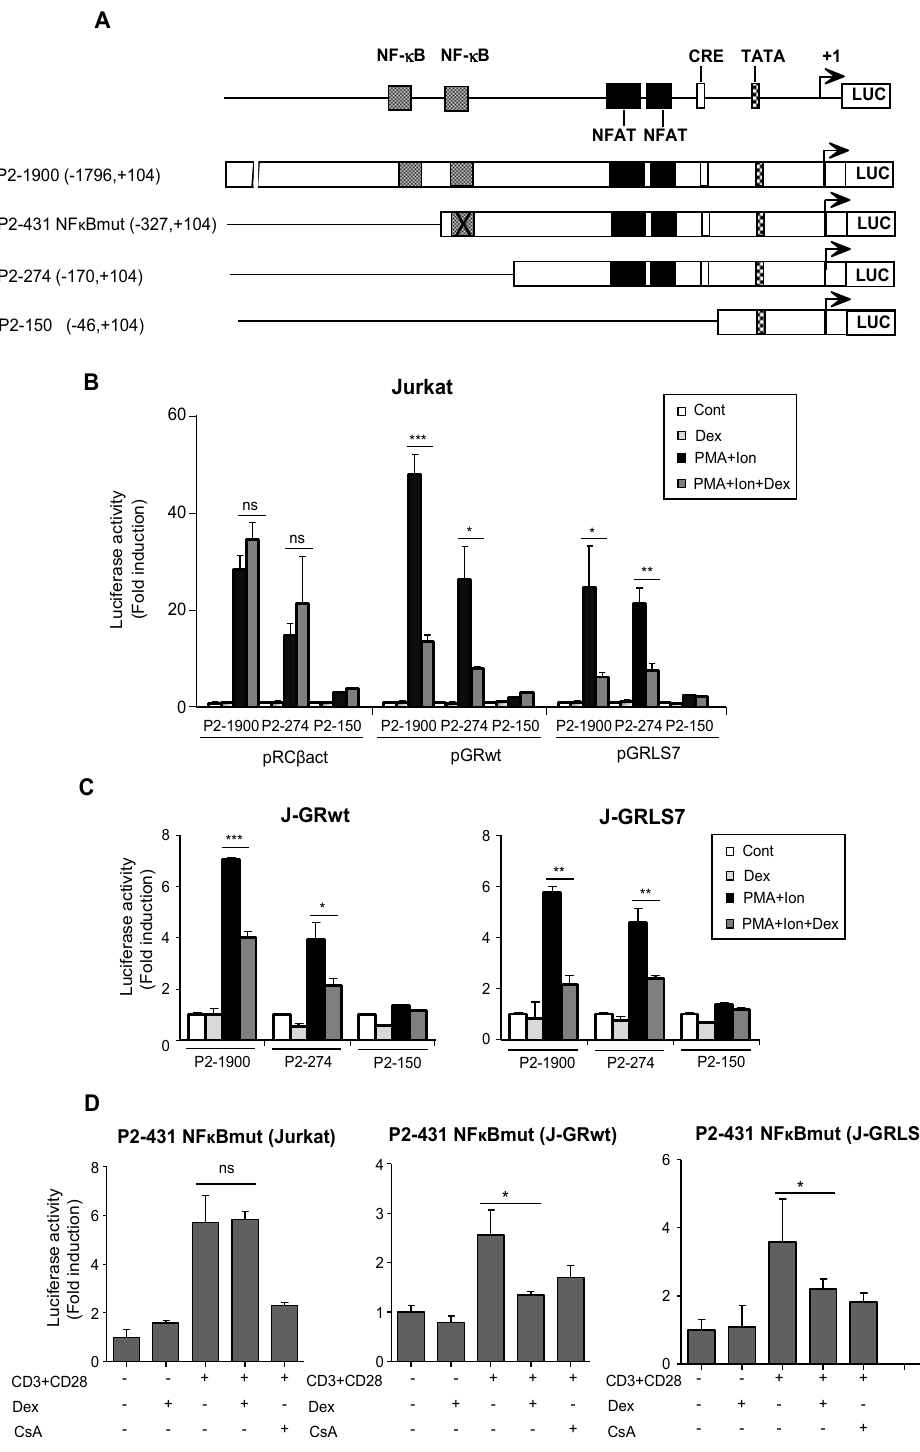
Figure 3. Dex effects on COX-2 promoter activity. ( A ) Schematic representation of the deletions ranging from − 46 to − 1796 bp relative to the transcription start site of the COX-2 promoter. Cis-acting consensus sequences are denoted by boxes. Jurkat cells were transfected with the indicated COX-2 promoter constructs and cultured in the absence (Cont) or presence of PMA + Ion or CD3/CD28 Abs for 18 h and assayed for luciferase activity. Dex (1 µ M) was added 1 h before stimulation. ( B )